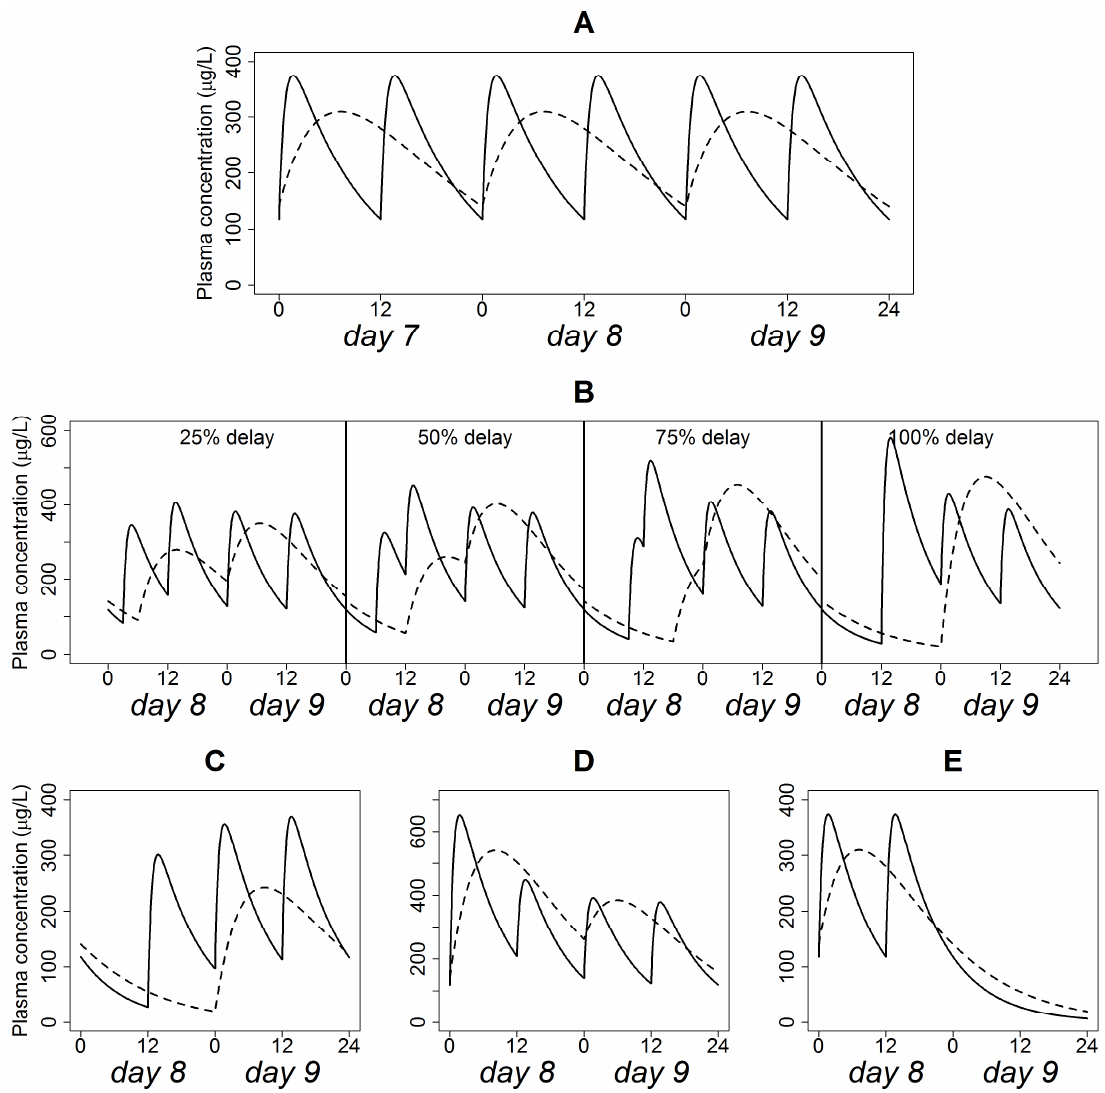
Figure 2. Quetiapine plasma concentration time profiles in a typical patient following the administration of 200 mg BID IR (solid line) and 400 mg QD XR (dashed line) formulations, assuming dose adherence ( A ), delay ( B ), omission ( C ), doubling ( D ) and discontinuation ( E ).